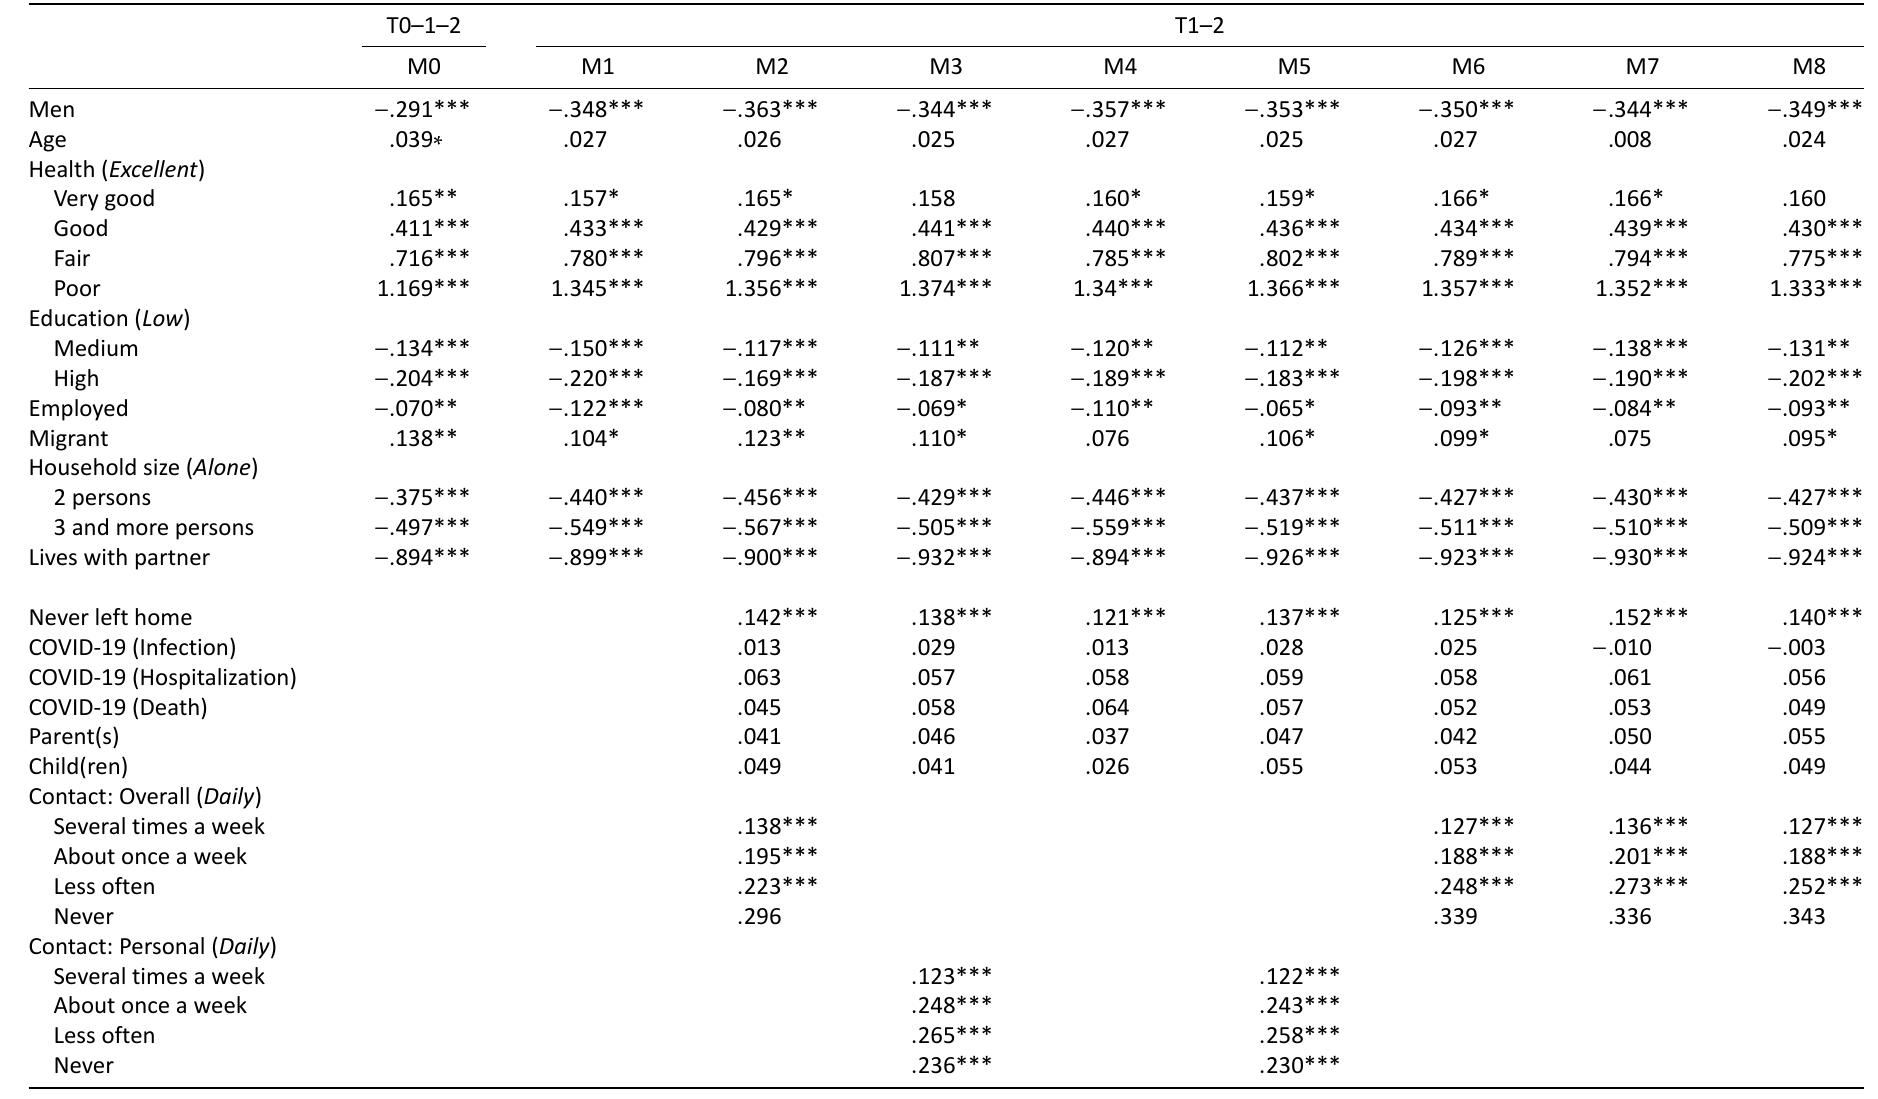
Table 1. Patterns of loneliness before and during the